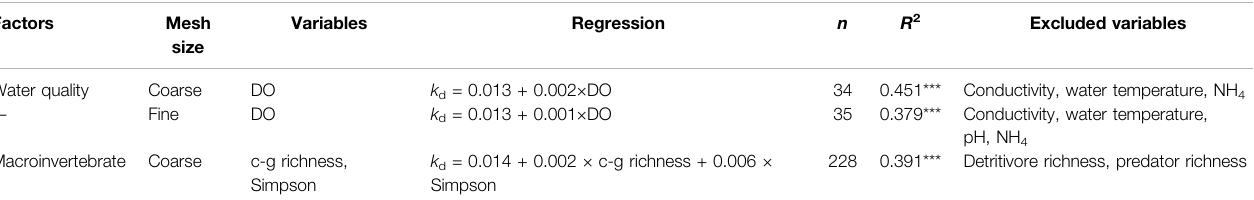
TABLE3| Resultsofmultiplelinearregressionanalysesofleaflitterbreakdownratesinstreamswithwaterqualityandmacroinvertebratecommunities.* p < 0.05,** p < 0.01, *** p < 0.001. Factors